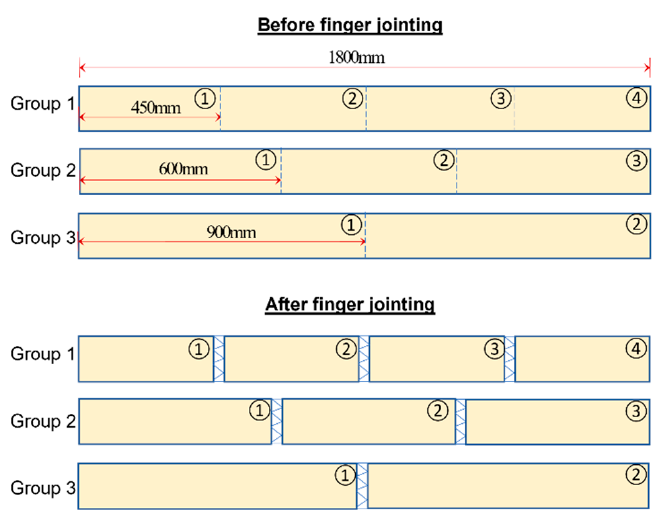
Figure 2. Schematic diagram of cutting and re-joining the boards.